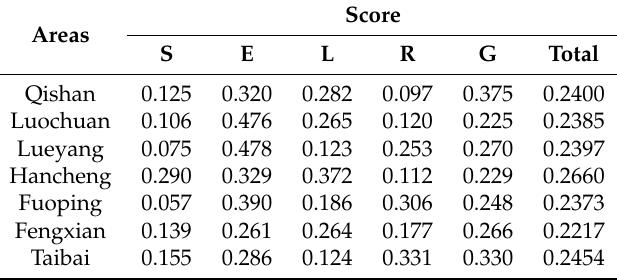
Table 5. Regional score of green development level weak.